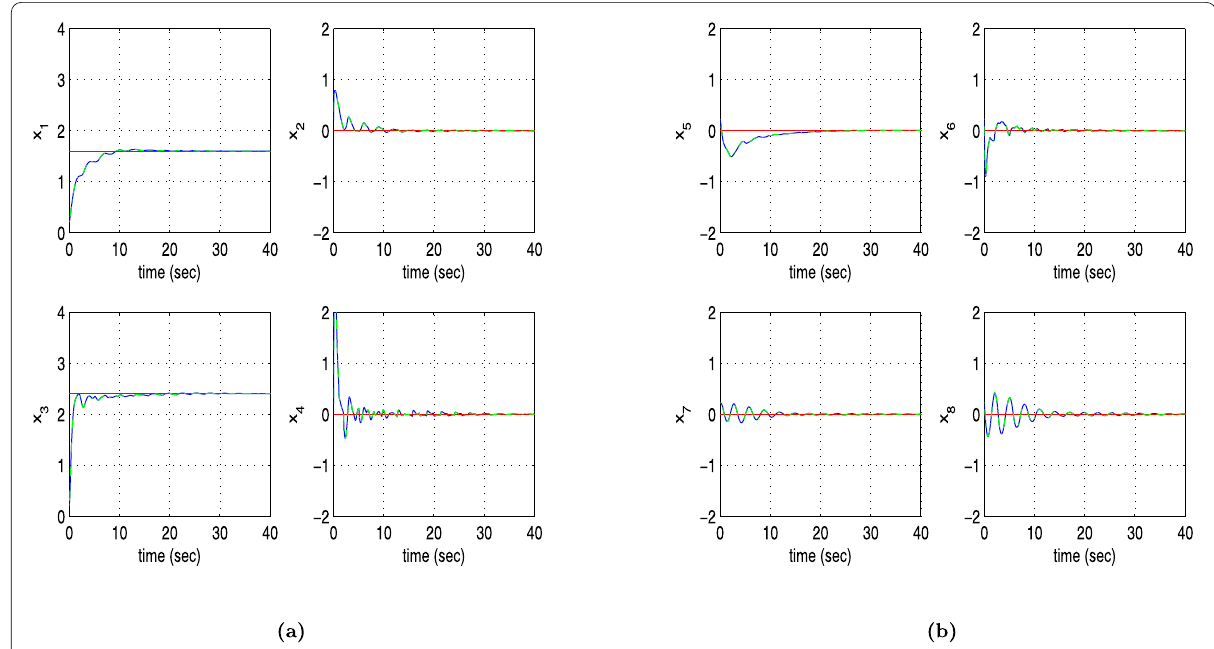
Figure 4 Tracking of setpoint 1 for the tower crane ( a ) control inputs u 1 , u 2 applied to crane, ( b ) tracking error variables e 1 , e 3 , e 5 , e 7 of the tower crane